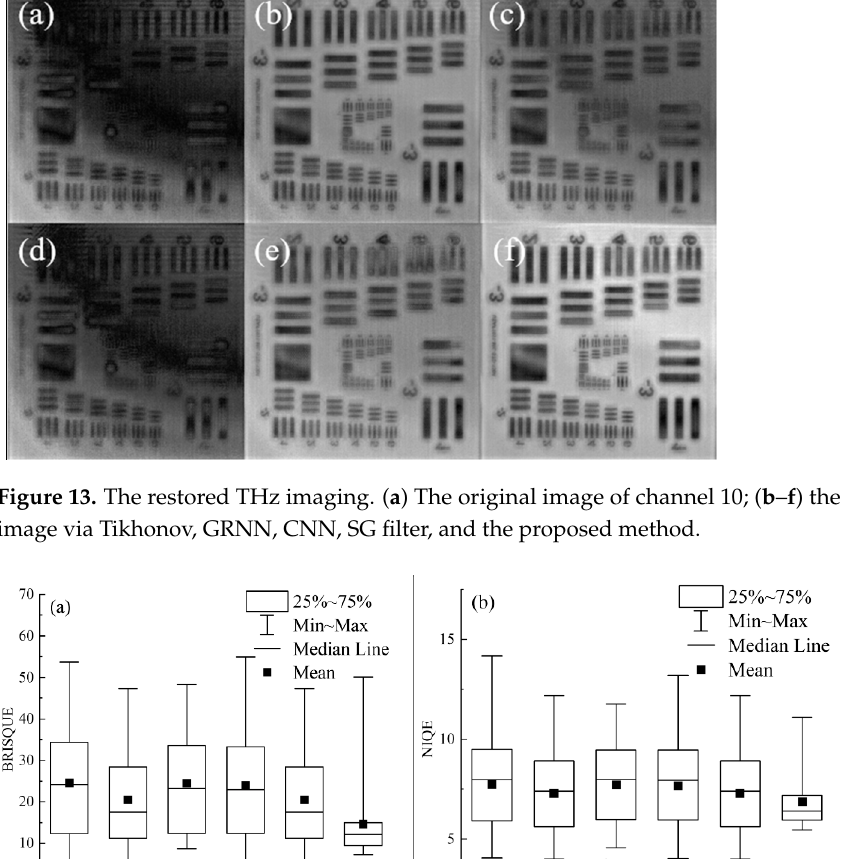
Figure 12. The quantitative denoising result with loss functions of fractional-order, integer-order, and no regularization terms. ( a ) RMSE. ( b ) R 2 . ( c ) SNR.